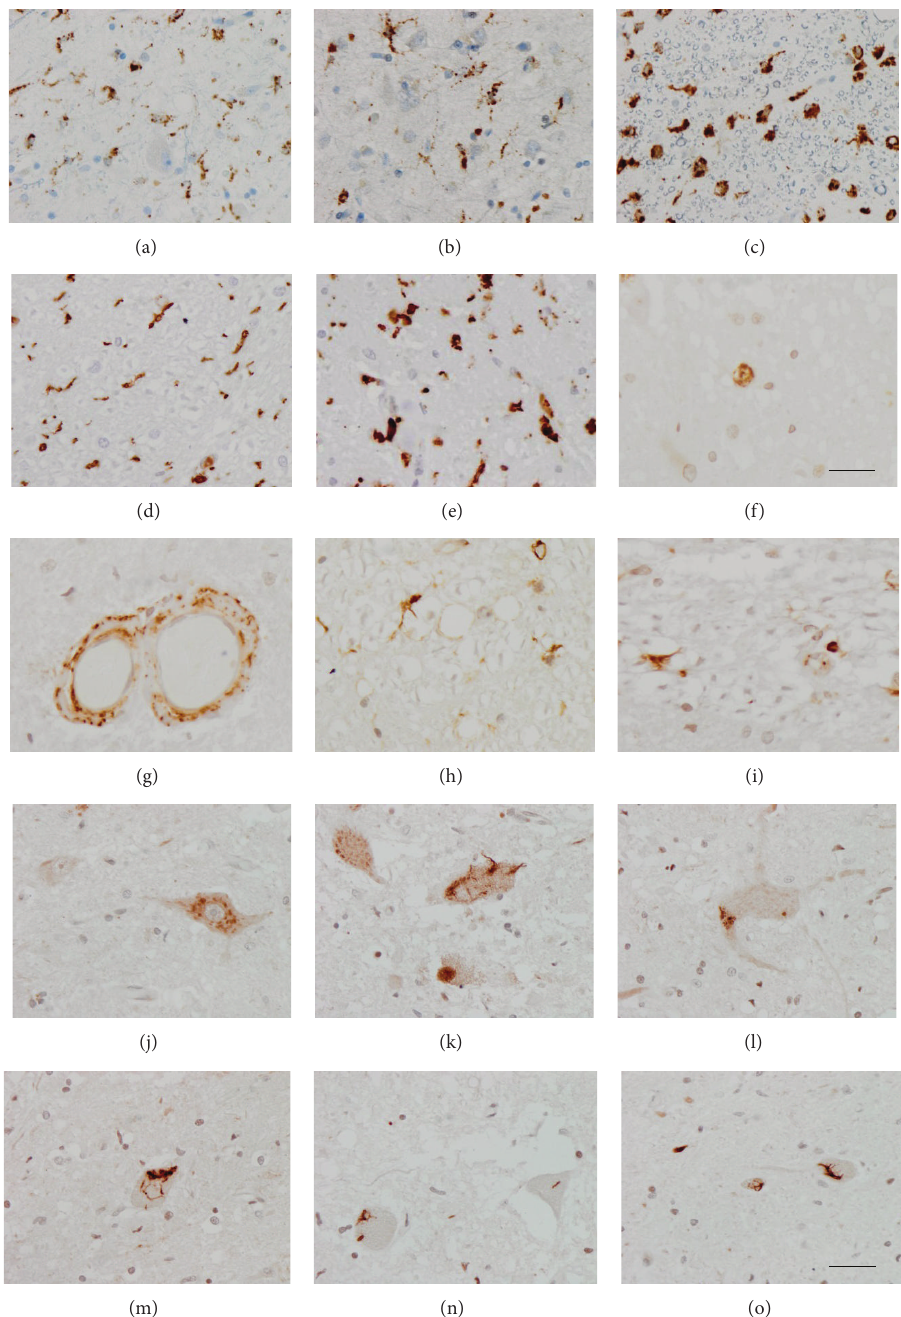
Figure 2: (a–c): CD68 immunohistochemistry shows amoeboid monocyte derived macrophages/microglia in the anterior lumbar horn (a and b) and pyramidal tracts (c) of the lumbar spinal cord in control (a) and ALS (b and c). (d and e) IBA1 stains immunoreactivity is present in large numbers of monocyte derived macrophages/microglia in the lateral pyramidal tract in control (D) and ALS cases with predominance of amoeboid cells in disease. (f) TNF- 𝛼 is localized in a few round cells of undetermined origin. (g–i) IL-6 immunoreactivity is found in the wall of blood vessels (g) and in scattered microglial cells (h and i). (j and k) IL-1 𝛽 immunoreactivity is present in neurons in control (j) and ALS cases but increased immunoreactivity and abnormal distribution of IL-1 𝛽 is observed in a few motor neurons of the lumbar spinal cord only in ALS (k). (l–o) Strong IL-10 immunoreactivity is seen in cytoplasmic inclusions in ALS reminiscent of ubiquitinated, TDP-43-positive inclusions currently found in motor neurons in sALS. Paraffin sections, slight haematoxylin counterstaining, bar in (o) valid for all figures = 30 𝜇 m, excepting bar in F = 50 𝜇